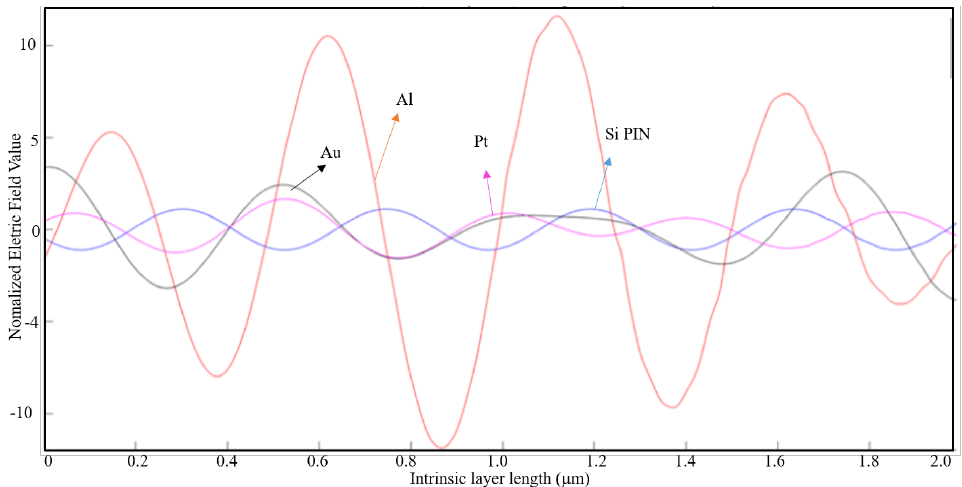
Figure 19. 1D Plot of the normalized electric field, z-component, along the intrinsic zone for different nanoantenna material types: Si PIN junction (blue), Al nanoantenna (red), Au nanoantenna (black), and Pt nanoantenna (magenta) (3-slit array; light wavelength: 1550 nm; metal thickness: λ /100; and air slit width: λ